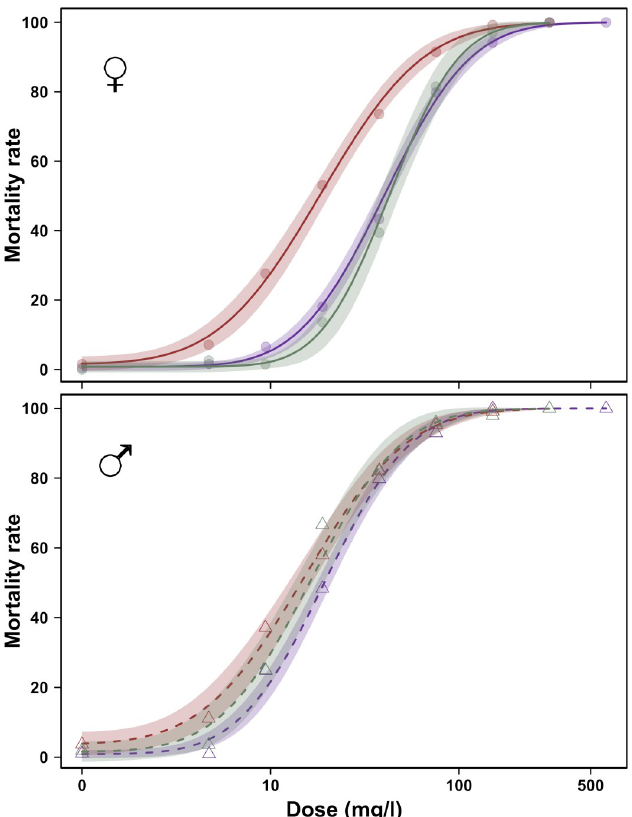
Fig 2. Effect of age class on LD 50 in a D . suzukii population. Results obtained after 24 h tarsal exposure to phosmet for females (upper panel) and males (lower panel). Red, green and blue represent the 0–24 h, 24–48 h and 72–96 h age classes, respectively. Dose-response curves and 95% confidence intervals were derived from the dose-response